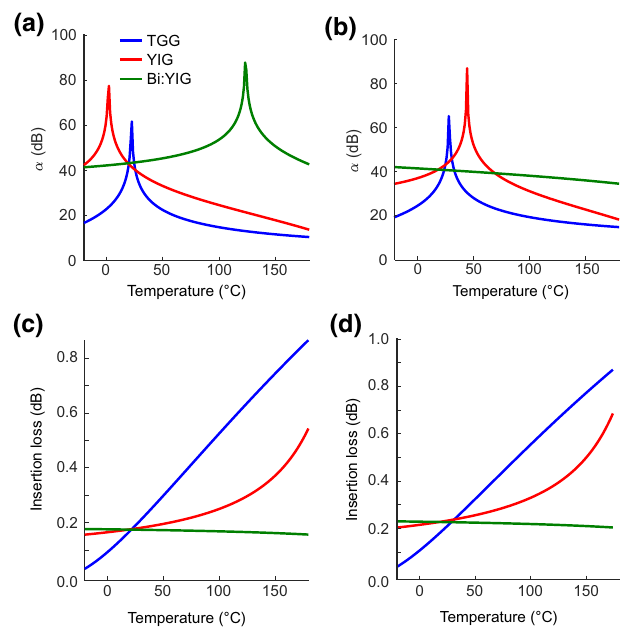
FIG. 9. Dependence of the isolation coefficient (a),(b) and insertion loss (c),(d) on temperature for TGG, YIG, and Bi:YIG. Panels (a) and (c) correspond to θ = 44.43 ◦ ; panels (b) and (d) correspond to θ = 45.57 ◦ .